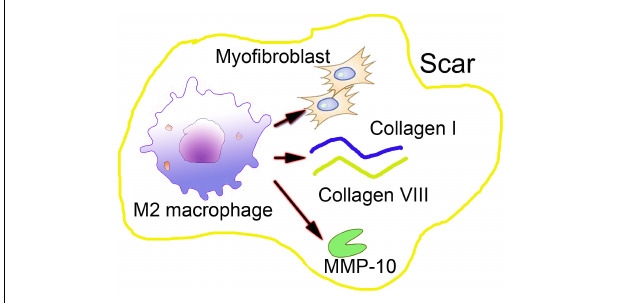
FIGURE 1 | The direct effects of macrophages in abnormal scar formation.